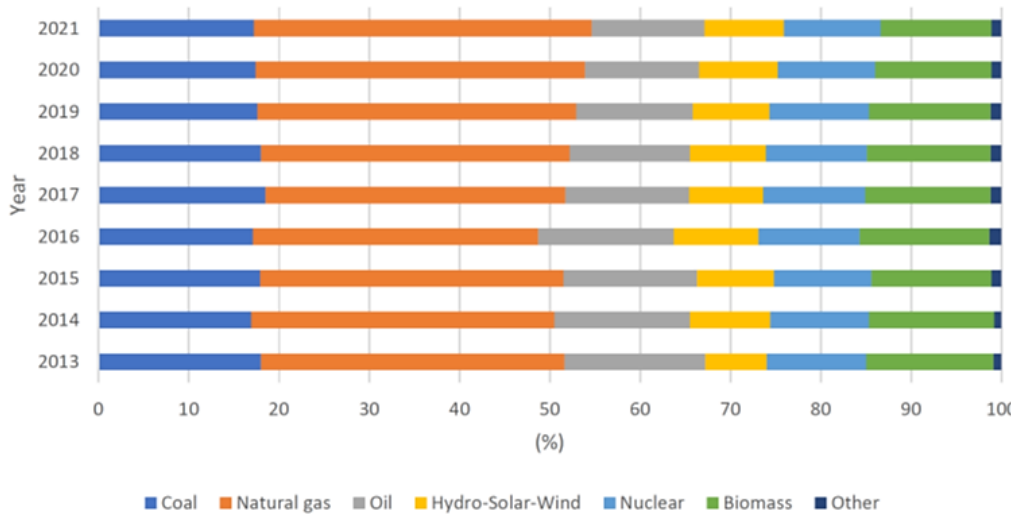
Figure 8. The energy mix of the electricity production in Romania (historical, current, and forecast) [35]. Table 2. CO 2 and NOx emissions intensities, depending on the energy mix for the year 2019 [11,34].